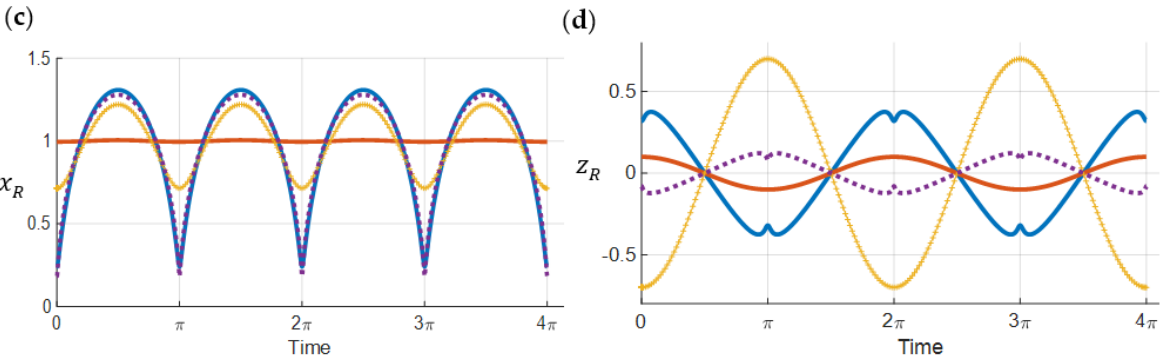
Figure 1. ( a ) The complex trajectories in the real x - z plane starting from initial positions: (𝜌(0), 𝑧 (0)) = (0.4,0.8) , (1,0.1) , (1, −0.7) , and (0.2, −0.4) , are displayed, respectively, by solid-blue line, solid-red line, dashed-purple line, and solid-yellow line. ( b ) The four trajectories with different initial positions have the same period of 2𝜋 . ( c ) The time responses of 𝑥 𝑅 = Re(𝜌sin𝜃) os-cillate with respect to its equilibrium position 𝑥 𝑅 = 1 . ( d ) The time responses of 𝑧 𝑅 = Re(𝜌cos𝜃) oscillate with respect to its equilibrium position 𝑧 𝑅 = 0 .